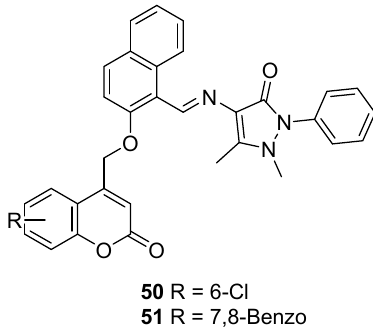
Figure 18. Coumarin-pyrazole hybrids and their MIC values against S. aureus .